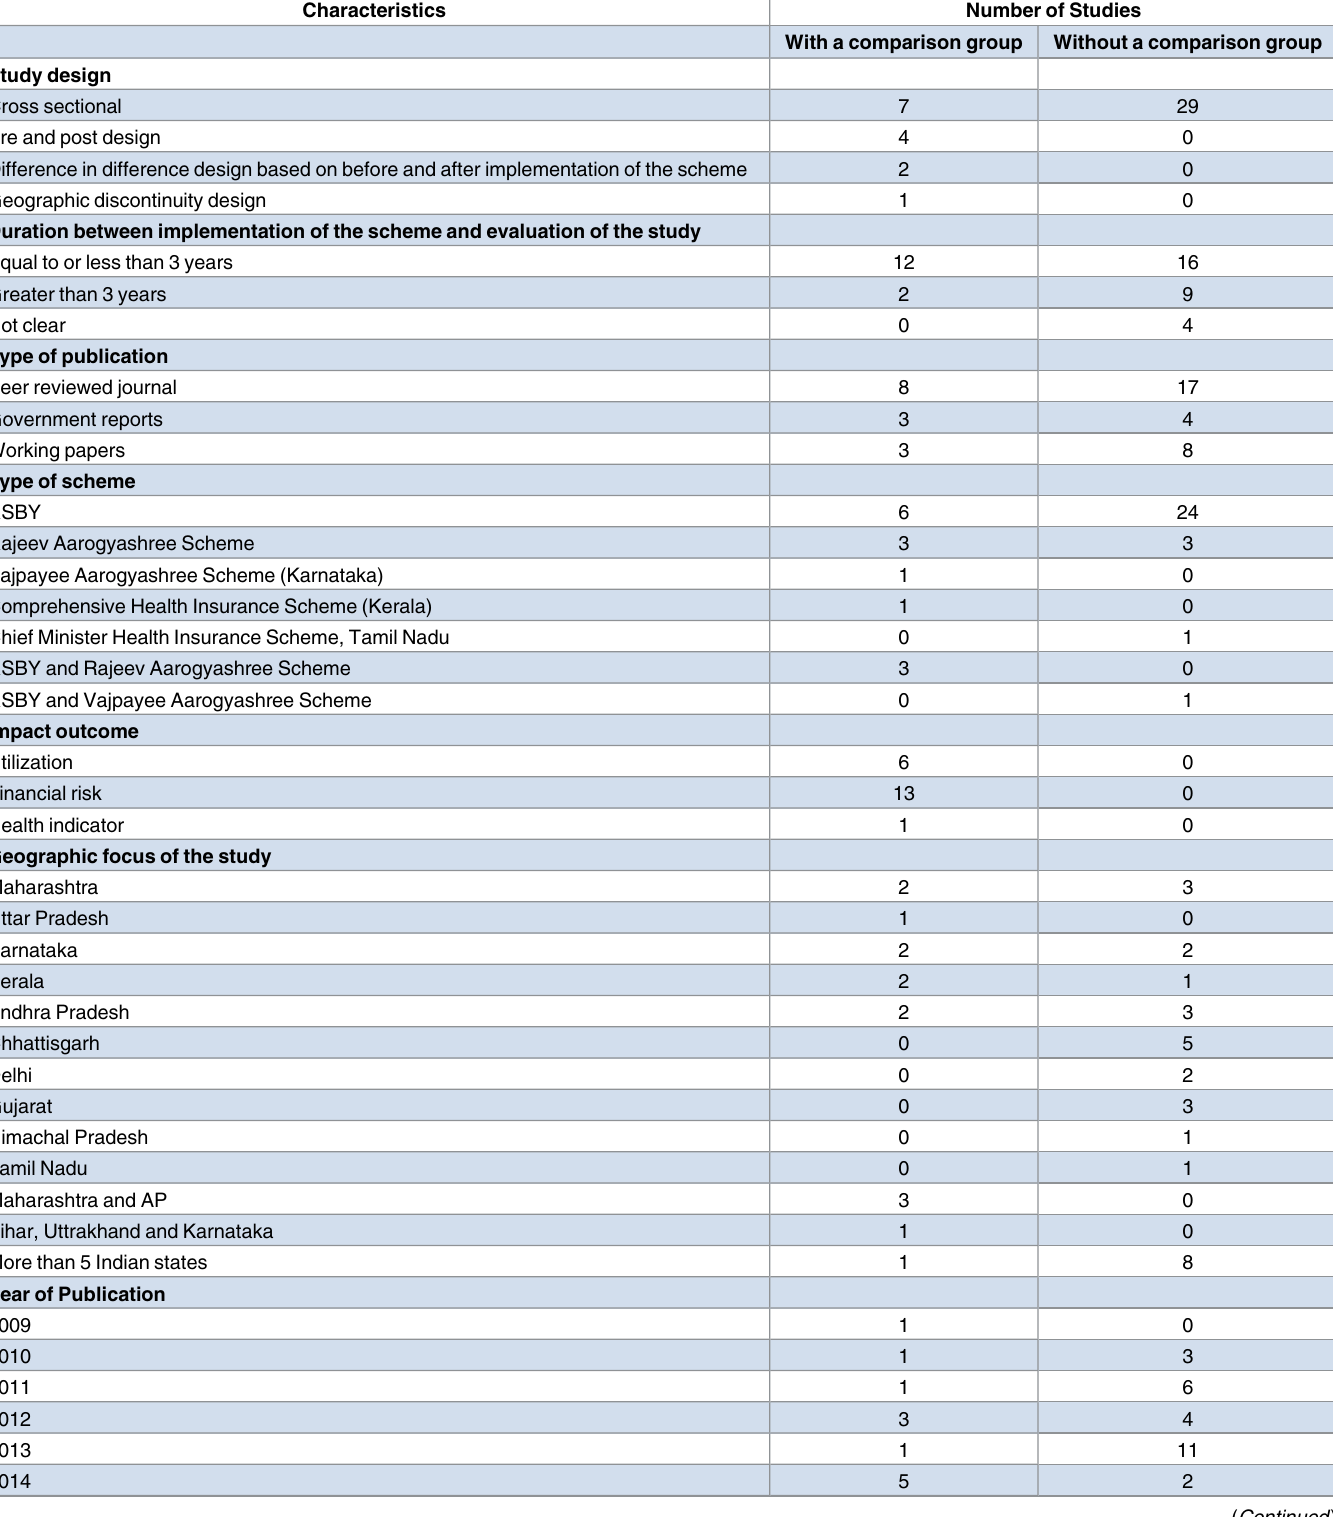
Table 1. Characteristics of the selected